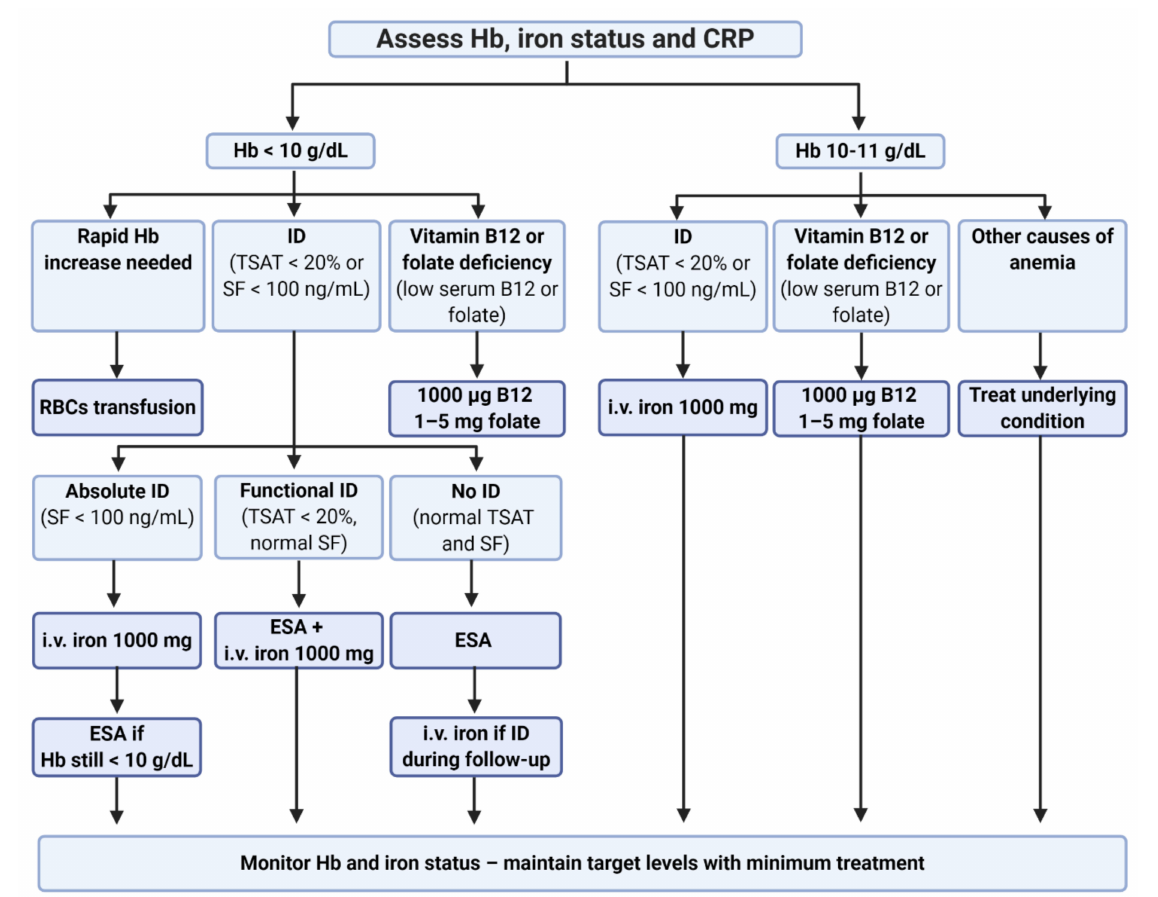
Figure 3. Management of anemia in cancer patients according to ESMO guidelines [258]. Additionally to TSAT and SF, the percentage of hypochromic cells (%HYPO) > 5% and reticulocytes hemoglobin content (CHr) < 28 pg can be used to determine impaired iron status. ID can be treated with oral iron only if ferritin < 30 ng/mL and CRP < 5 mg/L. CRP—C-reactive protein, ESA—erythropoiesis-stimulating agent, Hb—hemoglobin, i.v.—intravenous, ID—iron deficiency, RBCs—red blood cells, SF—serum ferritin, TSAT—transferrin